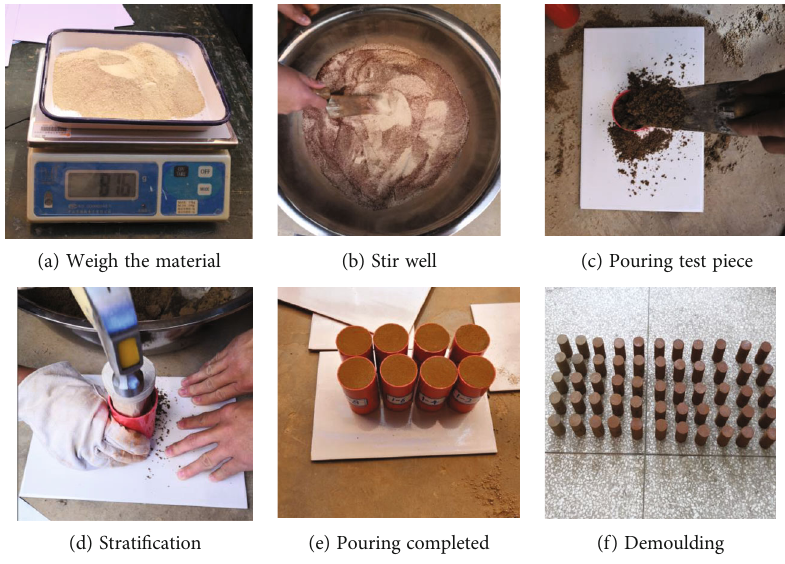
Figure 2: Pouring process of similar material specimen.